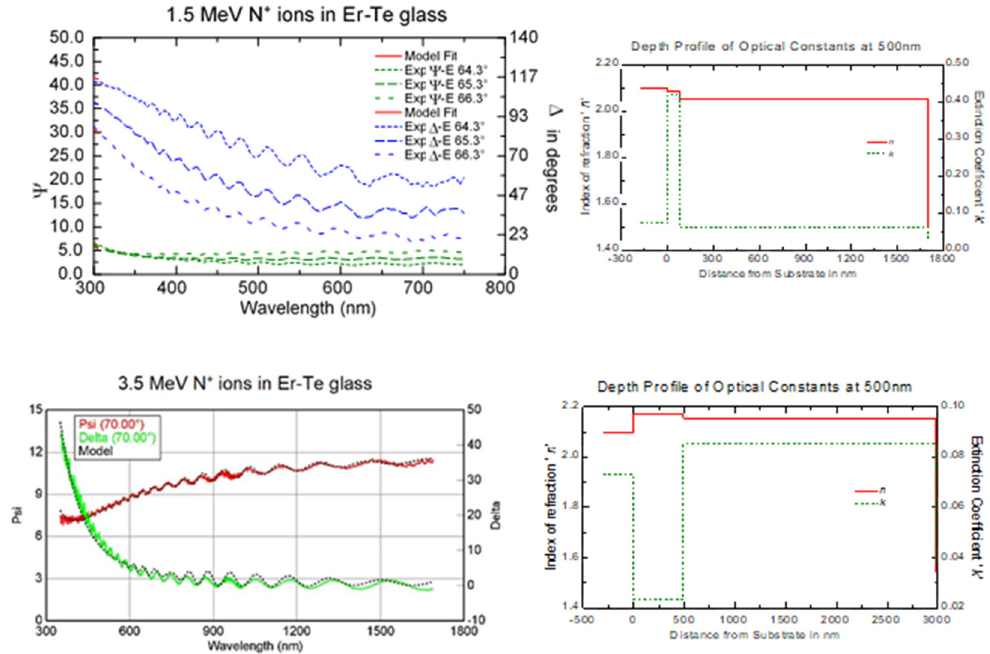
Figure 11. Measured (dotted) and fitted (solid lines) ellipsometric spectra (left column); refractive index (solid line) and extinction coefficient (dotted) depth-profile at λ = 500 nm (right column), calculated from the measured ellipsometric spectra of the left column. Ions: 1.5 MeV (upper row) and 3.5 MeV (lower row) N + ions in Er-Te glass. Position and width of barrier layers, shown in Figure 2A,B were taken from the depth profile of refractive index in the right column of Figure 11.